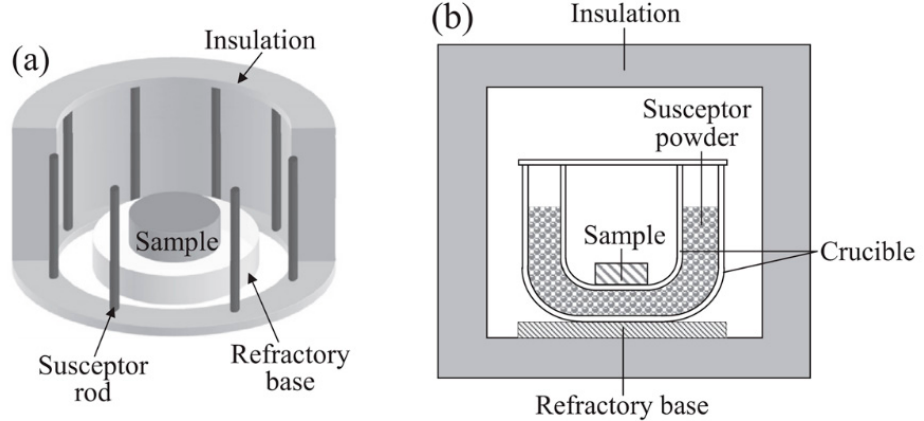
Figure 6. ( a ) Microwave-assisted solid-state synthesis setup with hybrid heating using SiC rods as susceptors. ( b ) MASS synthesis setup using a DMO. Susceptor surrounding the sample absorbs the microwave and initiate the heating [49]. Copyright © 2016, with permission from Elsevier.